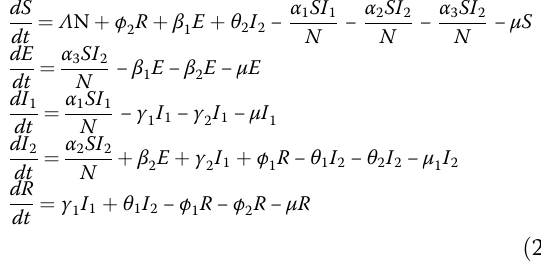
Endemic equilibrium and its